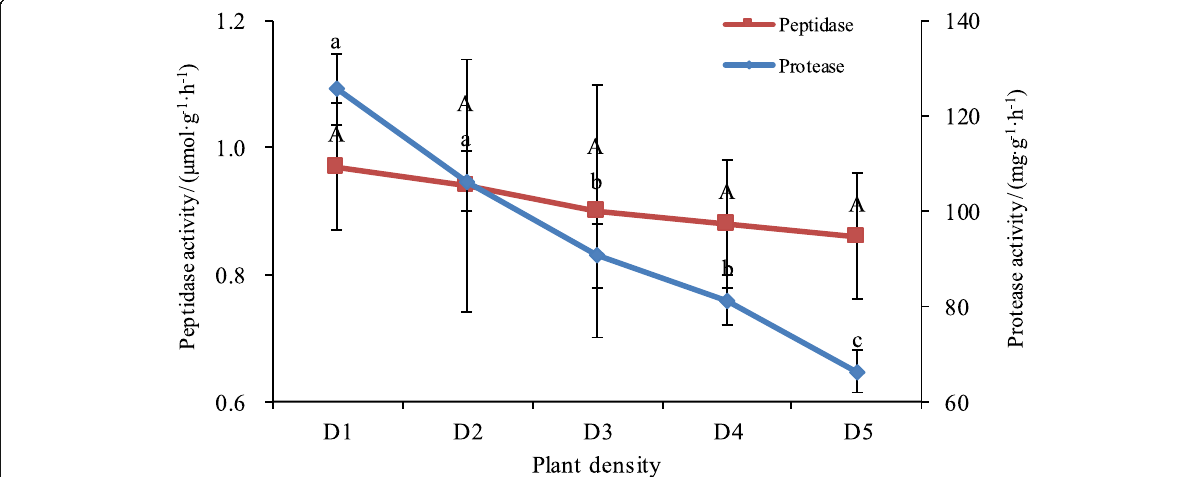
Fig. 6 The protease and peptidase activity in boll wall under different planting densities in 2018. D1-D5: 15 000, 25 000, 45 000, 60 000, and 75 000 plants per hectare. The vertical bar represents S.E. of the mean ( n = 3) when the value exceeds the size of the symbol. Lowercase letters indicate significance analysis among protease activity, and capital letters indicate significance analysis among peptidase activity. The same letter among treatments is not significantly different ( P ≥